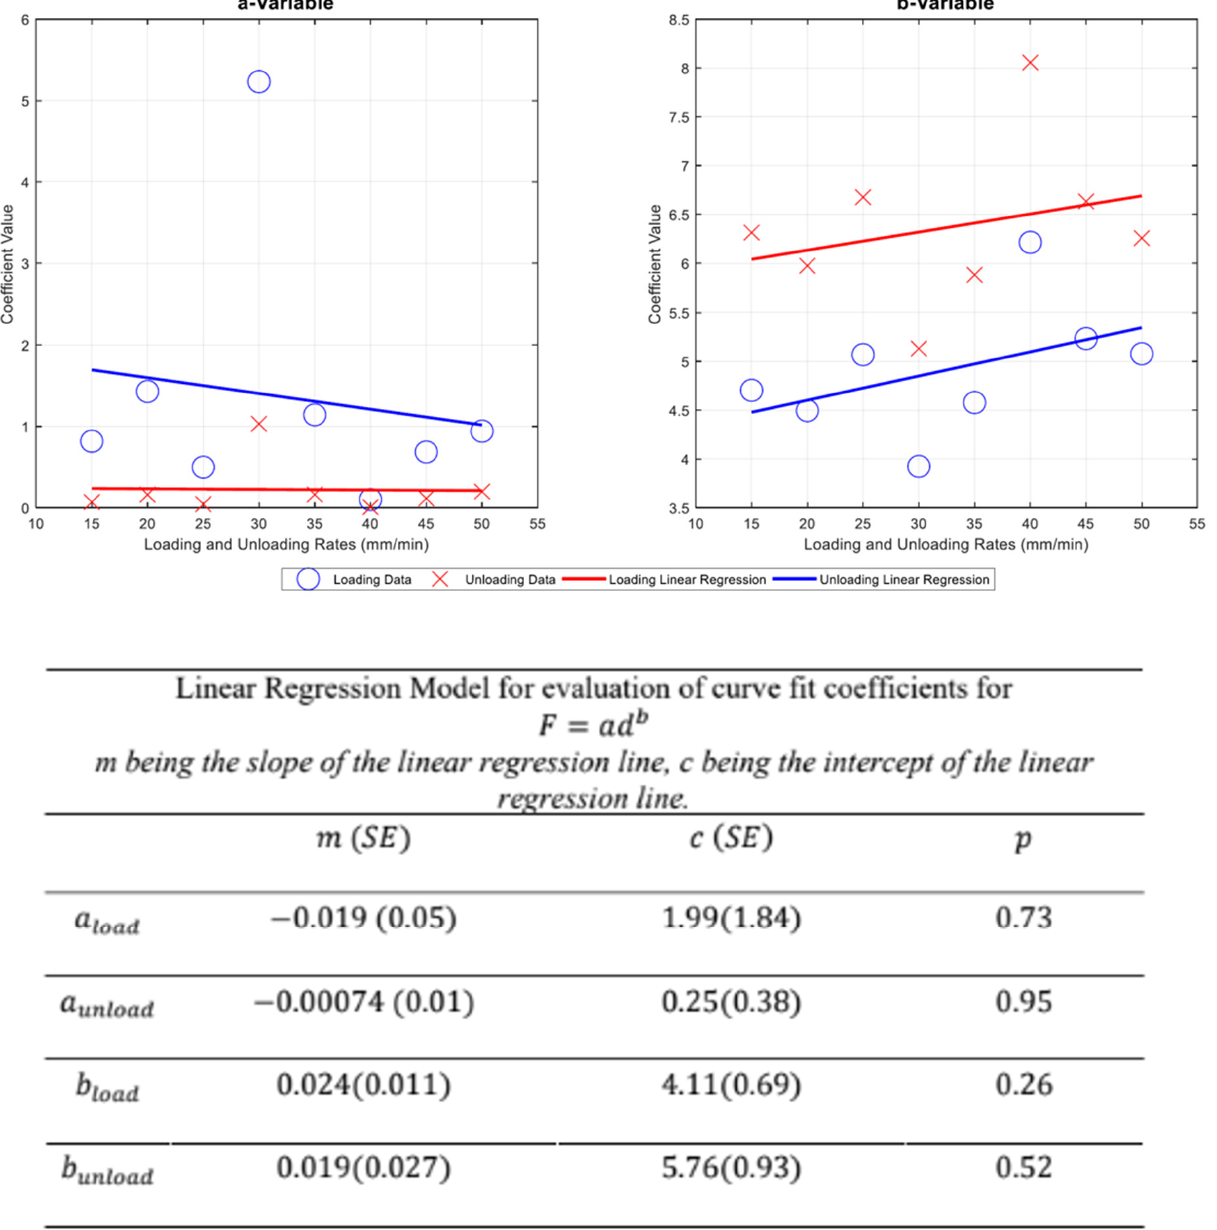
Figure 22. Plot of mean values for Figure 19 with Linear Regression Model Fitted.